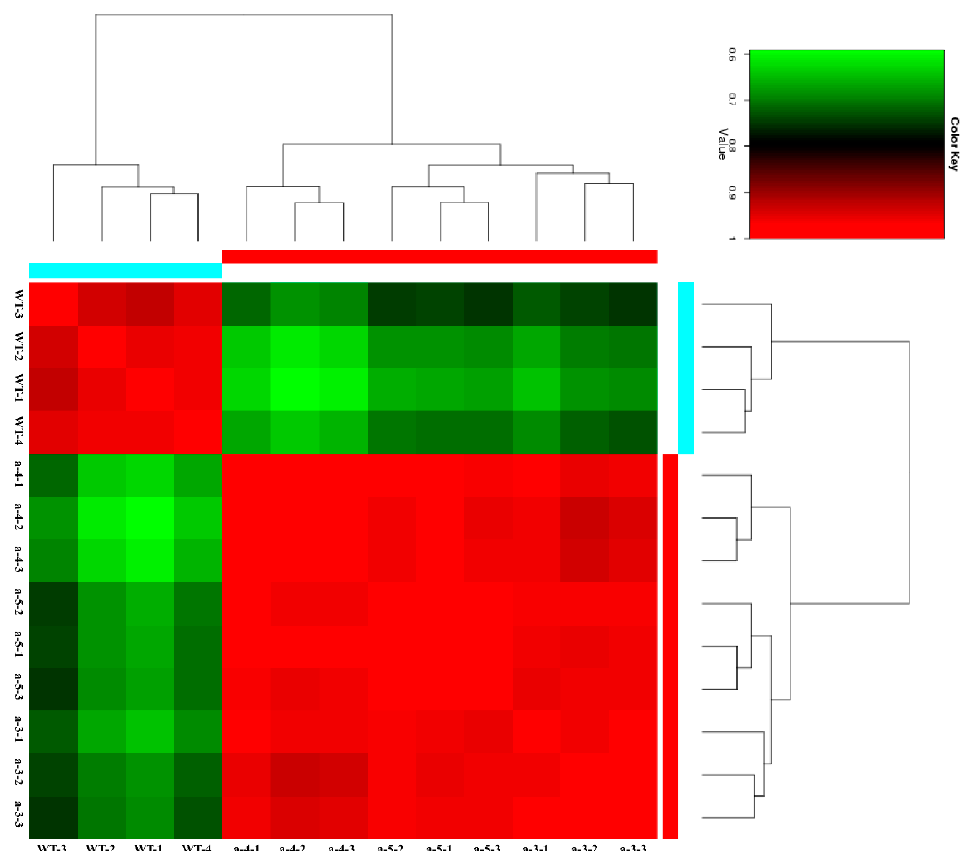
Figure 1. Pearson’s correlation coefficients among the samples. WT represents wild embryogenic cultures and a represents transgenic embryogenic cultures, including a-3, a-4, and